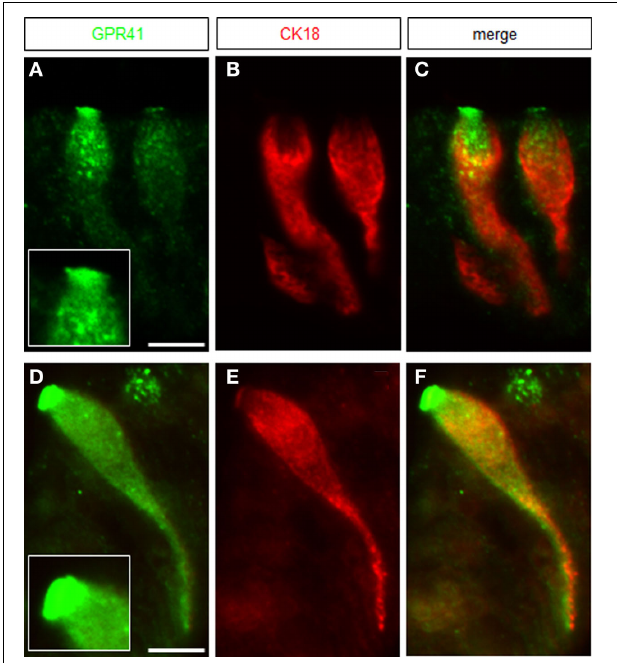
FIGURE 2 | Magnification of GPR41 immunoreactive brush cells. (A) GPR41 immunostaining (green) was most intense at the apical cell pole revealing a dense brush of microvilli, enlarged in the inset boxed area . (B) Immunostaining for CK18-antibody resulted in strong labeling of the cytoplasm exhibiting a different staining pattern than the GPR41-antibody. (C) Overlay of (A) and (B) pointed out the differing staining patterns of both antibodies. (D) Immunoreactivity for GPR41-antibody (green) labeled the entire cell body with the most intense staining of the apical microvilli. Notable was the long basolateral process of the cell. (E) Immunofluorescence for CK18 was mainly concentrated in the cytoplasm of the cell. (F) Overlay of (D) and (E) demonstrated colocalization of GPR41 and CK18 immunostaining in the cytoplasm including the long basolateral process whereas apical microvilli only were strongly stained by the GPR41-antibody. Scale bars : (A–F) = 10 μ m.